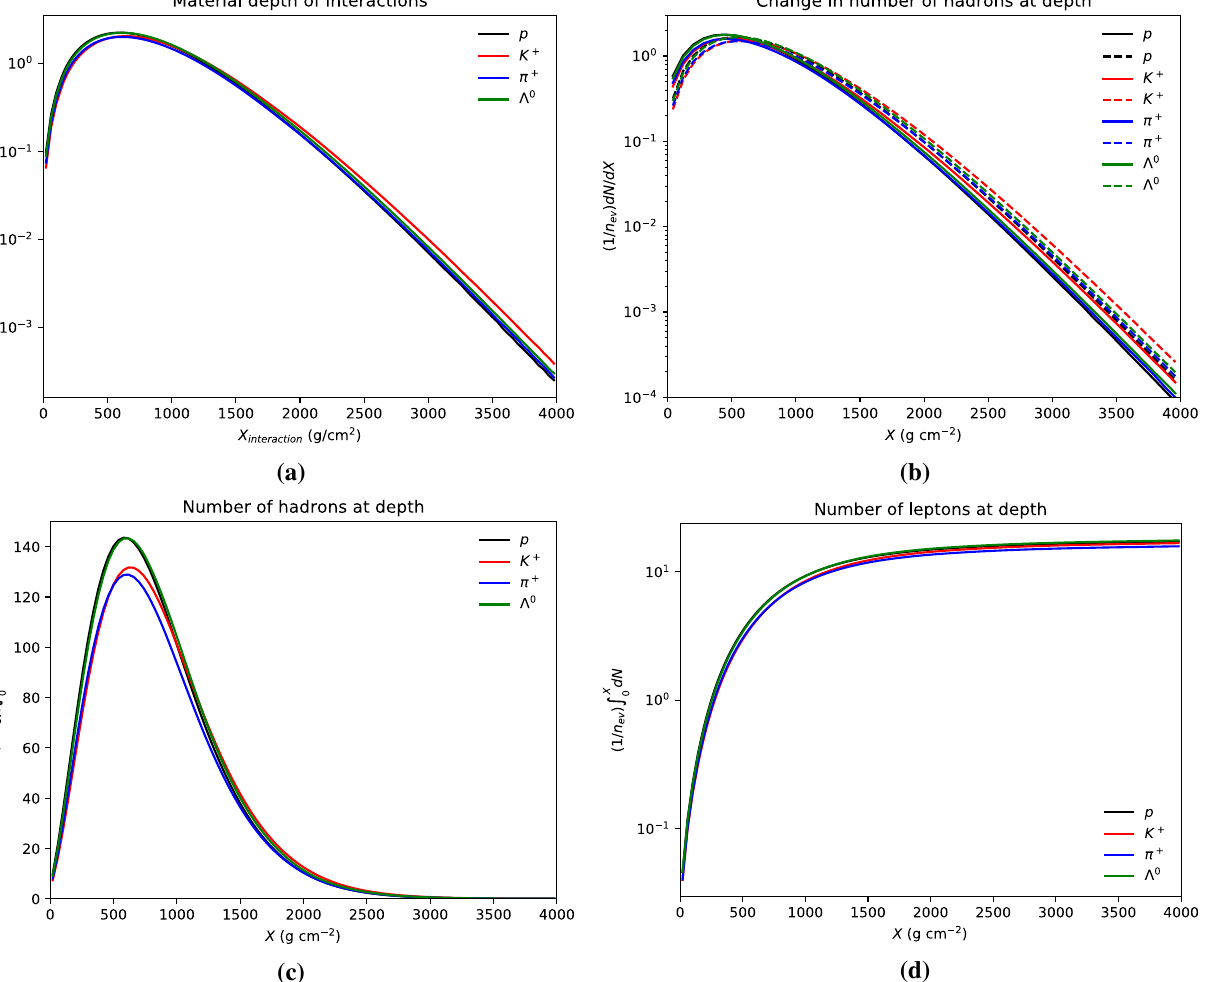
Fig. 15 Evolution of a cascade initiated by a 1000 GeV proton, π + , K + or (cid:3) 0 passing through a 3.5 m thick slab of lead. Shown is the num- ber of a interactions, b hadrons produced (full) and decayed (dashed),